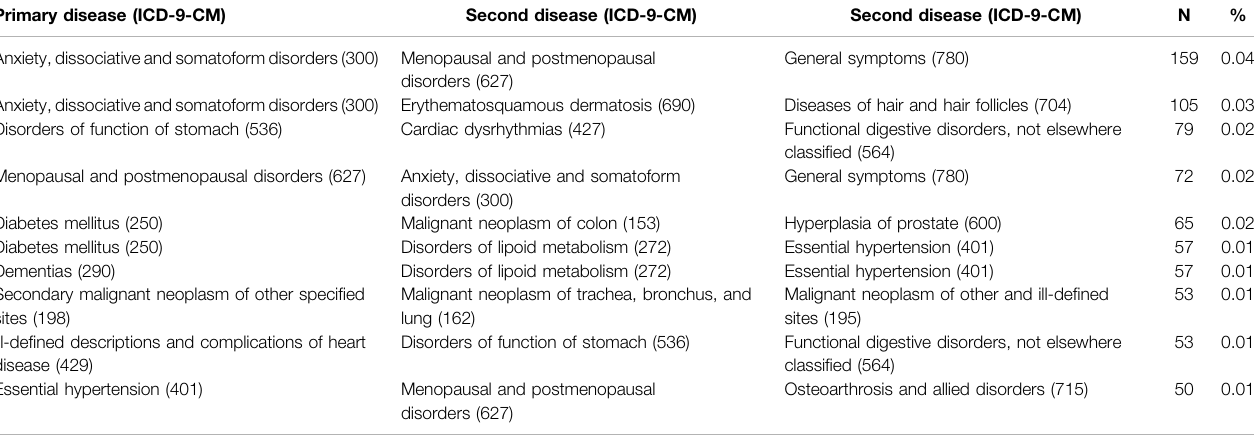
TABLE 4 | Top 10 combinations of three diseases treated with radix Salvia miltiorrhiza from 2000 to 2011 in Taiwan. Primary disease (ICD-9-CM) Second disease (ICD-9-CM)